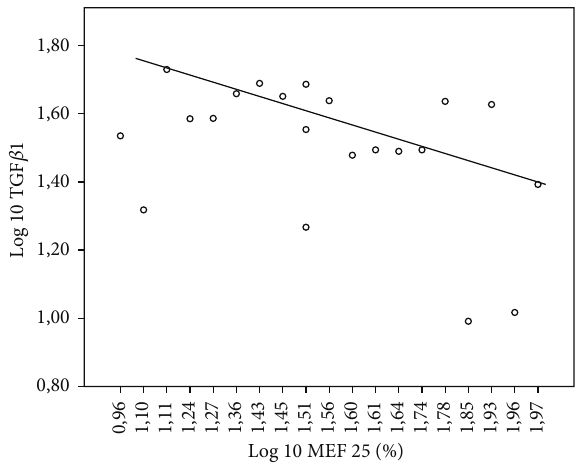
C − 509T subjects with one T (mutant = CT + TT) polymor- with one C polymorphism (mutant = CT +